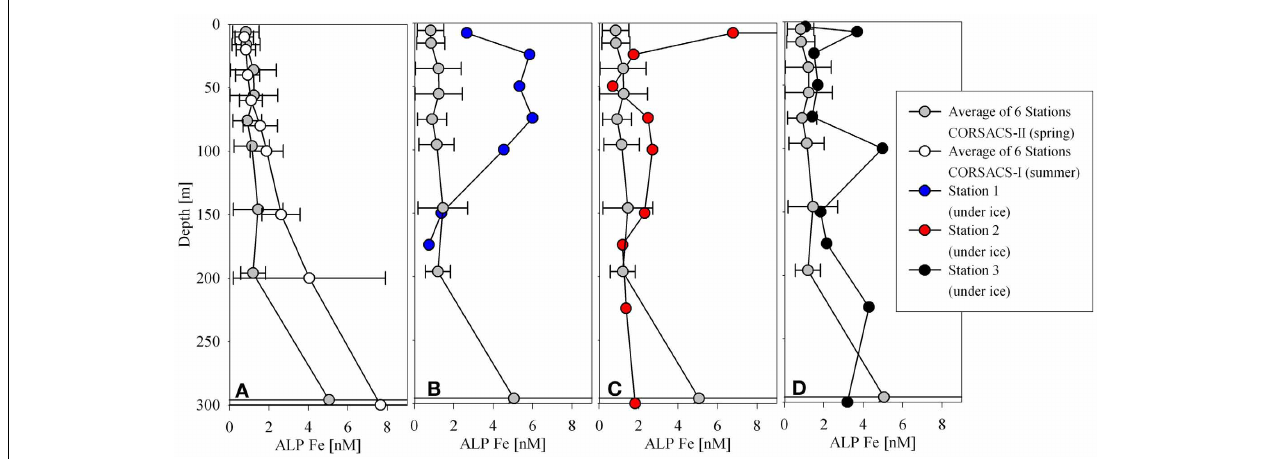
FIGURE 10 | A comparison of acid leachable particulate iron from the CORSACS expeditions (A, Sedwick et al., 2011) to acid leachable particulate iron profiles at Stations 1 (B), 2 (C), and 3